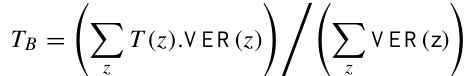
Fig. 4. A comparison of the Gaussian weighting function (centred on an altitude of 87km with a full width at half maximum of 8.7km) with the volume emission rate profile from She and Lowe (1998). The latter was used as the weighting function in deriving the OH-equivalent temperatures reported